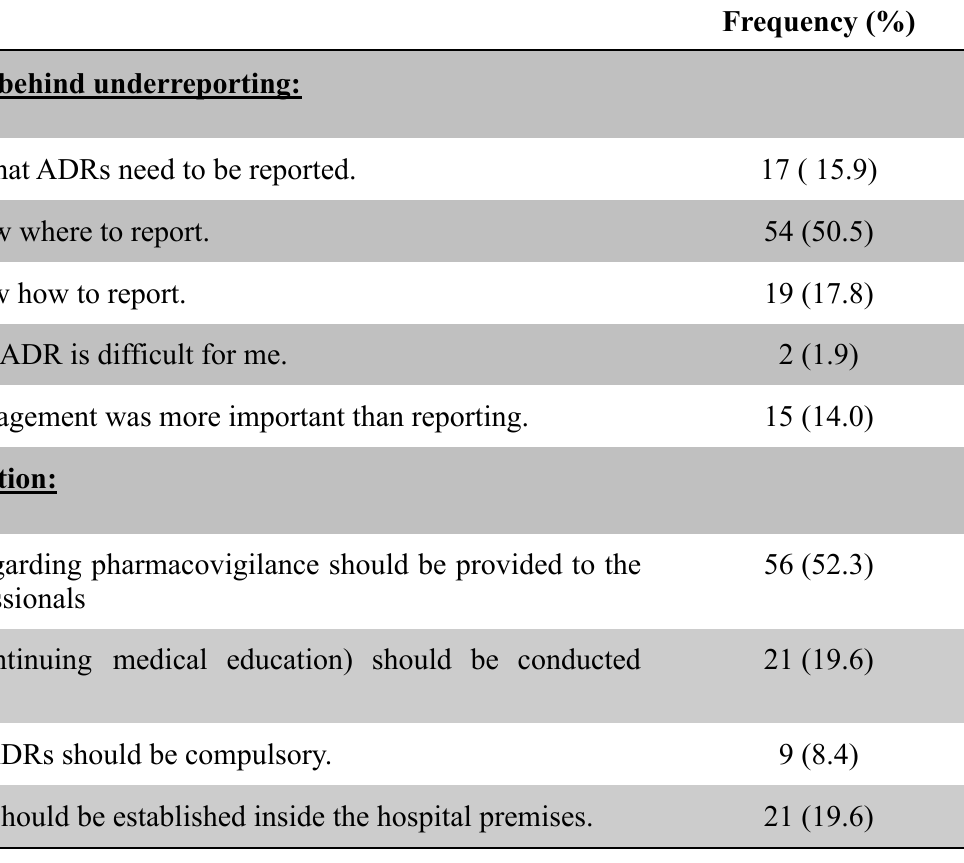
Table 4: Major factors discouraging adverse drug reaction (ADR) reporting and major suggestions to improve pharmacovigilance program (N=107)